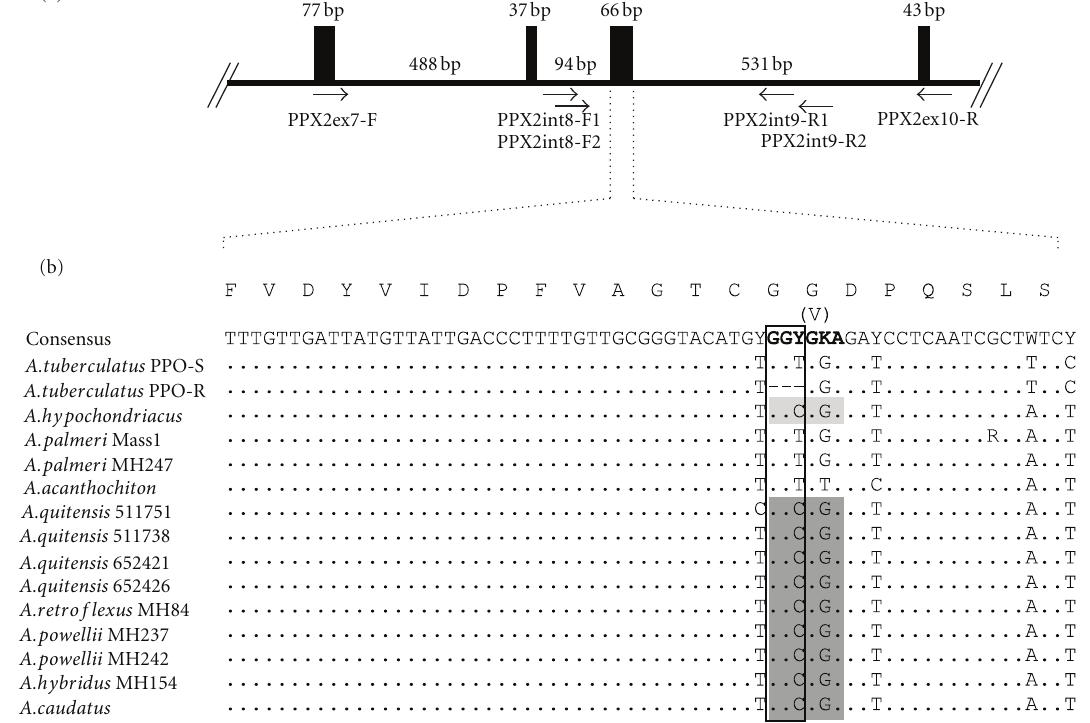
Figure 2: (a) Partial PPX2 gene structure showing exon/intron positions and sizes. (b) Alignment of exon 9 from di ff erent Amaranthus species. The consensus nucleotide sequence and translated amino acid sequence are at the top. Conserved nucleotides are represented by dots. The boxed codon indicates the site of the Gly210 deletion mutation that is present in the PPO-resistant biotype of A. tuberculatus (GenBank DQ394876) and not in the wild-type (GenBank DQ394875) or any of the other species. Sequences that are cleaved in the PCR- RFLP assay are indicated by the shaded box which depicts the EciI recognition site. An inferred amino acid change of Gly211 to Val211 is also shown that results from a G to T nucleotide polymorphism in the Gly211 codon in the sequence of A. acanthochiton . The PPX2 sequence of A. hypochondriacus is from GenBank